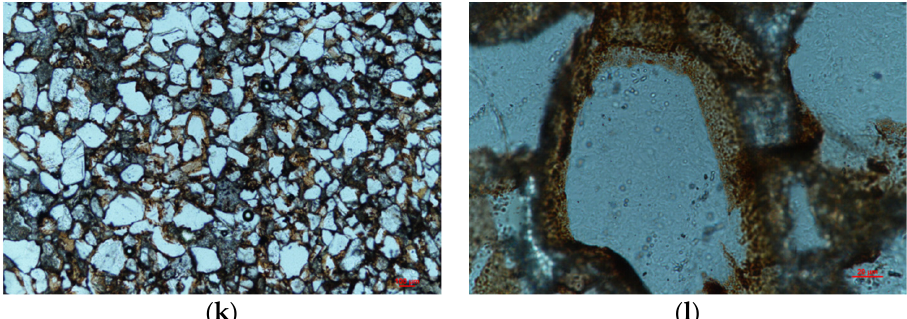
Figure 1. Microfacies analysis of thin sections of rock samples. ( a ) Carbonate A: bioclast. ( b ) Car-